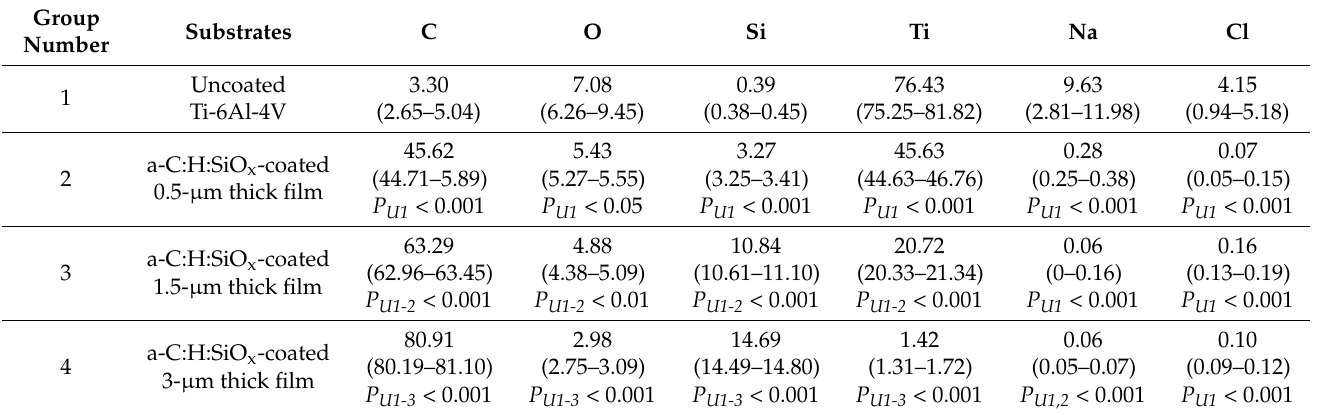
Table 5. Elemental (at.%) composition of Ti-6Al-4V substrate surface after five-week in vitro biodegra-